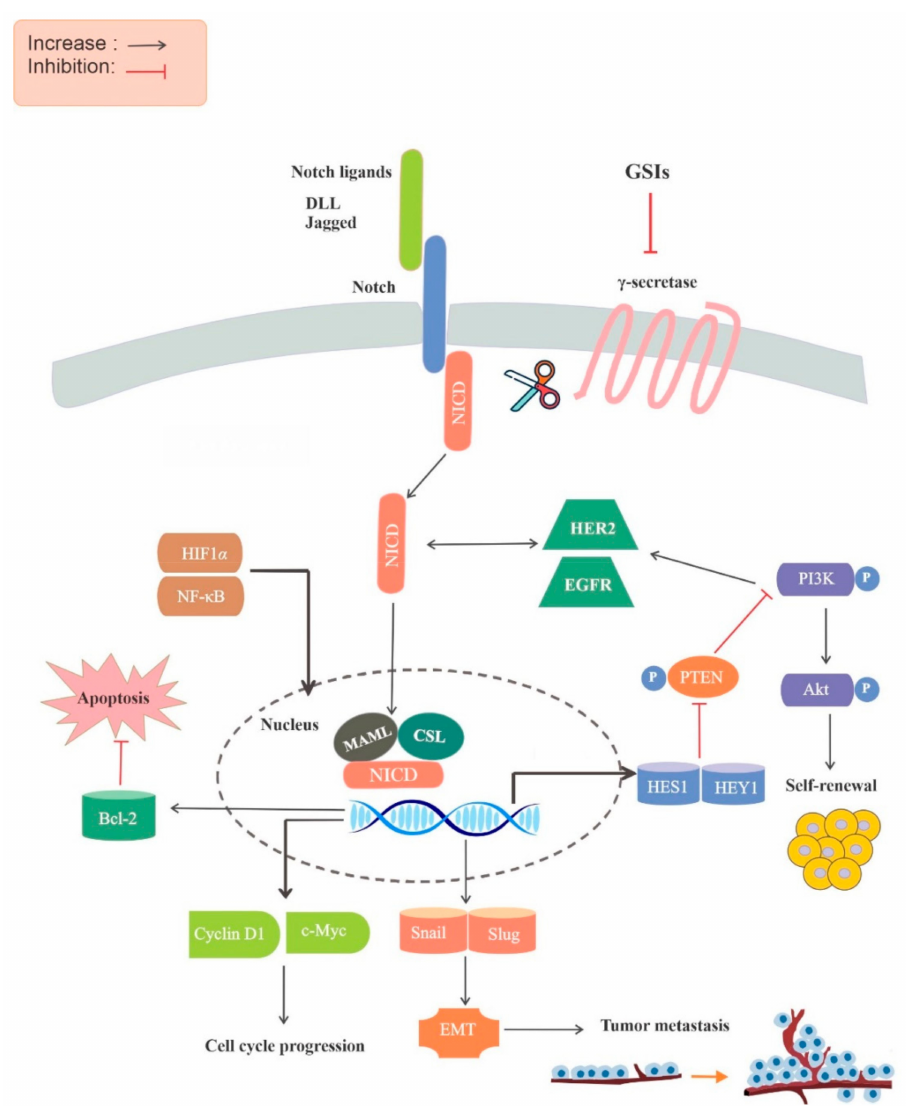
Figure 1. Molecular mechanisms underlying the anticancer properties of GSIs. First, the Notch receptor interacts with the Notch ligand, such as DLL, and initiates proteolytic cleavage at the extracellular site, followed by cleavage at the intracellular site by γ -secretase, leading to the release of NICD. Then, NICD is translocated into the nucleus, where it interacts with CSL and MAML to form a transcription-activating complex. GSIs can inhibit these steps, including receptor/ligand binding, the release of NICD, and the interaction of NICD and downstream targets, as well as NICD protein stability, and can thus have anticancer effects. Abbreviations: CSL, CBF1, suppressor of hairless and LAG1; DLL, Delta-like ligand; EGFR, epidermal growth factor receptor; EMT, epithelial-mesenchymal transition; GSIs, γ -secretase inhibitors; HER2, human epidermal growth factor receptor 2; HIF1 α , hypoxia-inducible factor 1 α ; MAML, mastermind-like; NF- κ B, nuclear factor-kB; NICD, Notch intracellular domain; PI3K, phosphatidylinositol-3-kinase; PTEN, phosphatase and tensin homolog. The oncogenic reach of the Notch pathway is partially due to its crosstalk with other signaling pathways; for example, Hedgehog, Janus kinase (JAK)/signal transducers and activators of transcription (STAT), receptor tyrosine kinases (RTKs), Wnt, and transforming growth factor- β (TGF- β ) decapentaplegic pathways. In addition to TGF- β and Wnt, vas- cular endothelial growth factor (VEGF), phosphatidylinositol 3-kinase (PI3K)/Akt, Ras, nuclear factor κ -light-chain-enhancer of activated B cells (NF- κ B), mammalian target of rapamycin (mTOR), hypoxia-inducible factor (HIF), and interleukin-6 (IL-6) are